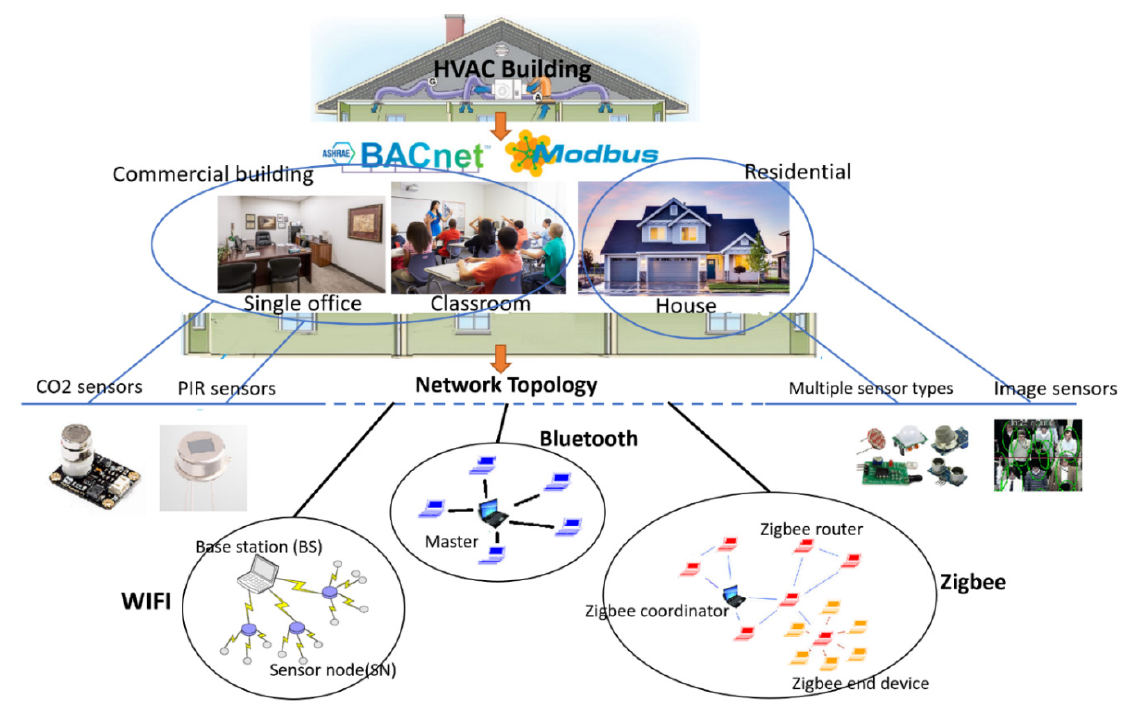
Figure 1. Overview of communication between the HVAC system and sensors.